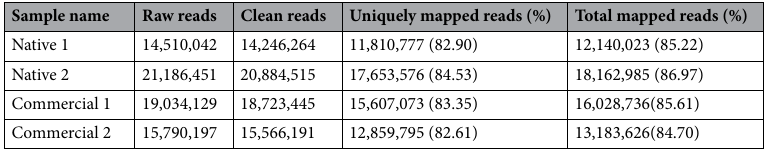
Table 1. Number of RNA-Seq reads and mapping rates of all